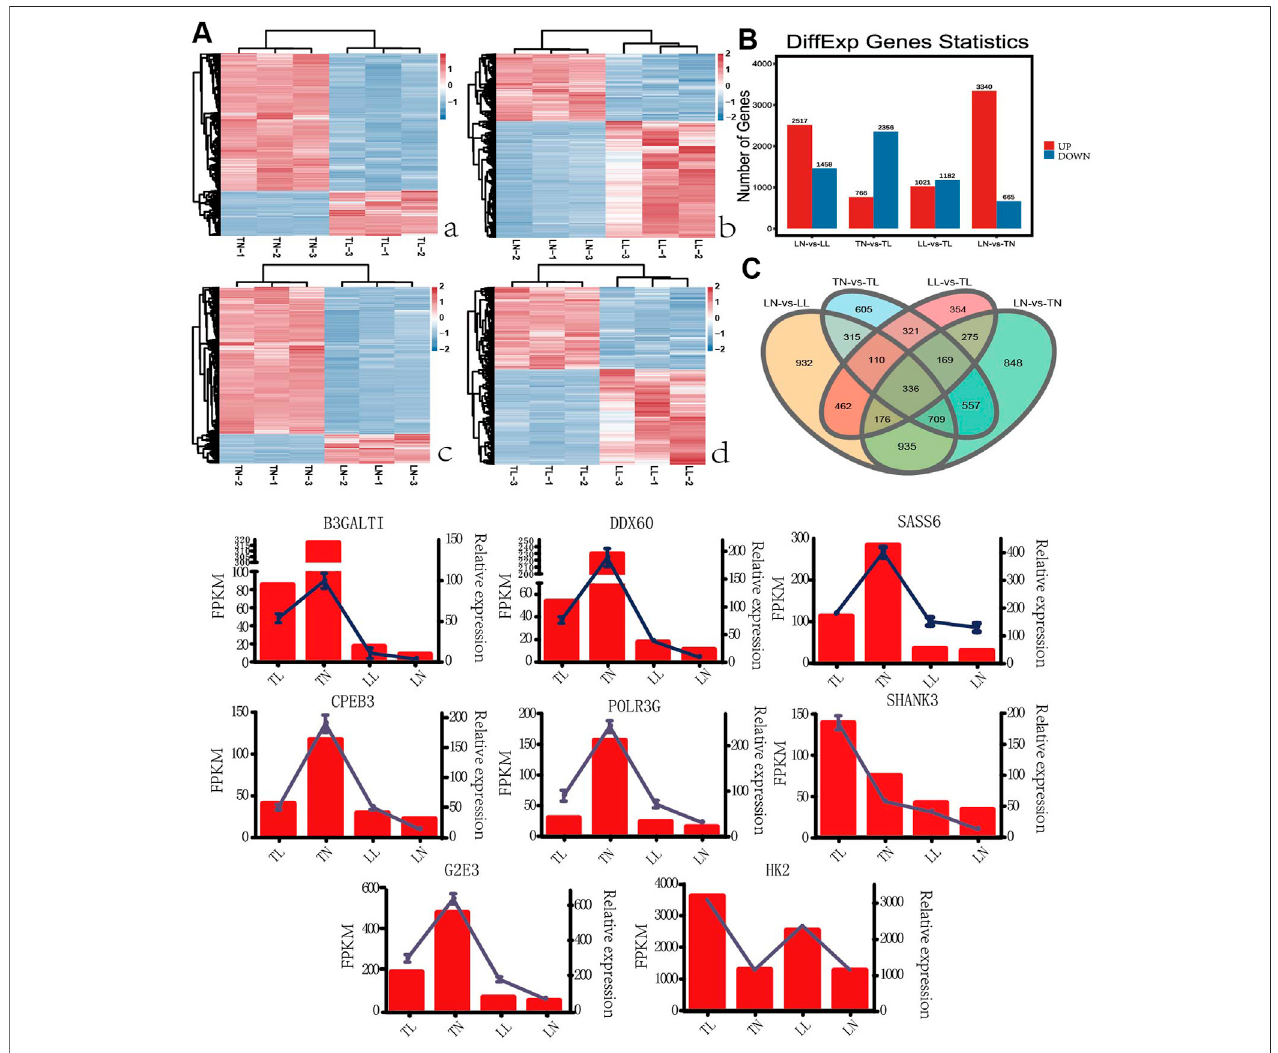
FIGURE1| EDGsexpressionresultsamongthefourgroupsbyRNA-seq. (A) TheheatmapshowstherelativeexpressionpatternsofDEGsamongthefourgroups. Eachcolumnrepresentsasample,andeachrowrepresentstheexpressionlevelsofasinglemRNAinvarioussamples.Thecolorscaleoftheheatmaprangesfromblue (low expression) to red (high expression). (a) Heatmap of DEGs for TN and TL groups. (b) Heatmap of DEGs for LN and LL groups. (c) Heatmap of DEGs for LN and TN groups. (d) Heatmap of DEGs for LL and TL groups. (B) The histogram shows the number of DEGs identi fi ed among the four groups. (C) Venn diagram of DEGs interactions based on the overlapping DEGs among the four groups. (D) Expression patterns of eight randomly selected DEGs. Histogram represent the change in transcript level according to the FPKM value of RNA-seq (left y-axis), and Broken line indicate that relative expression level defense by RT-PCR (right y-axis).